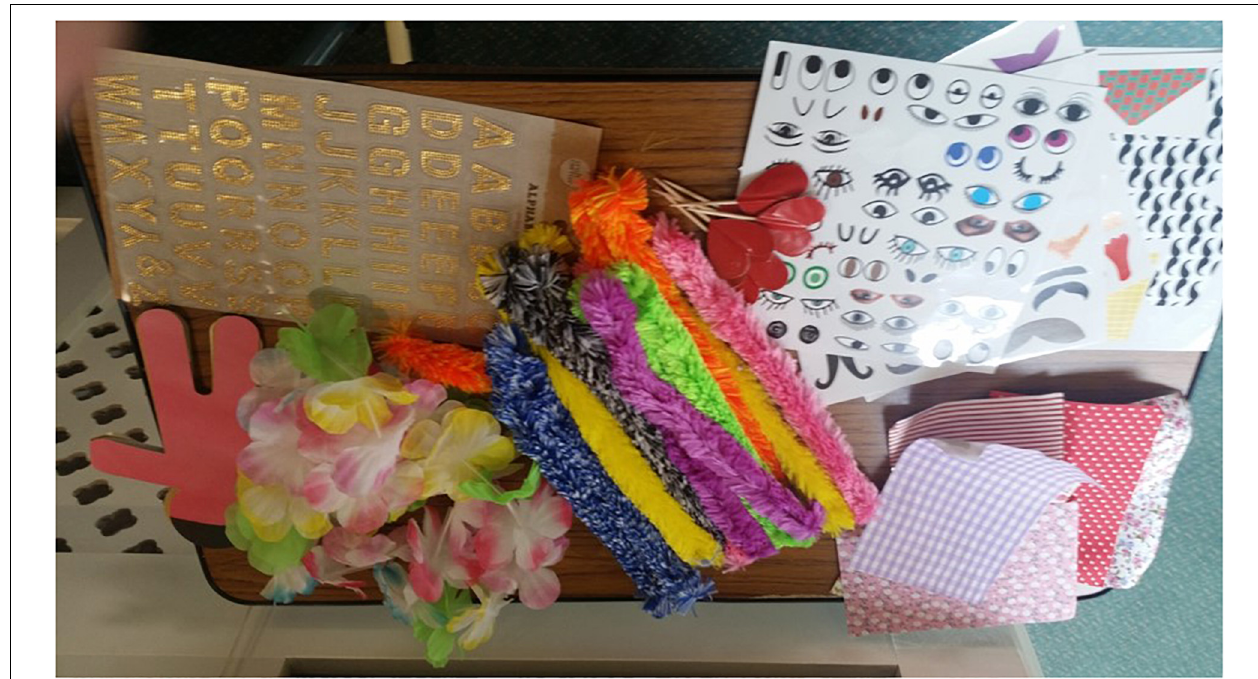
FIGURE 2 | Focus group